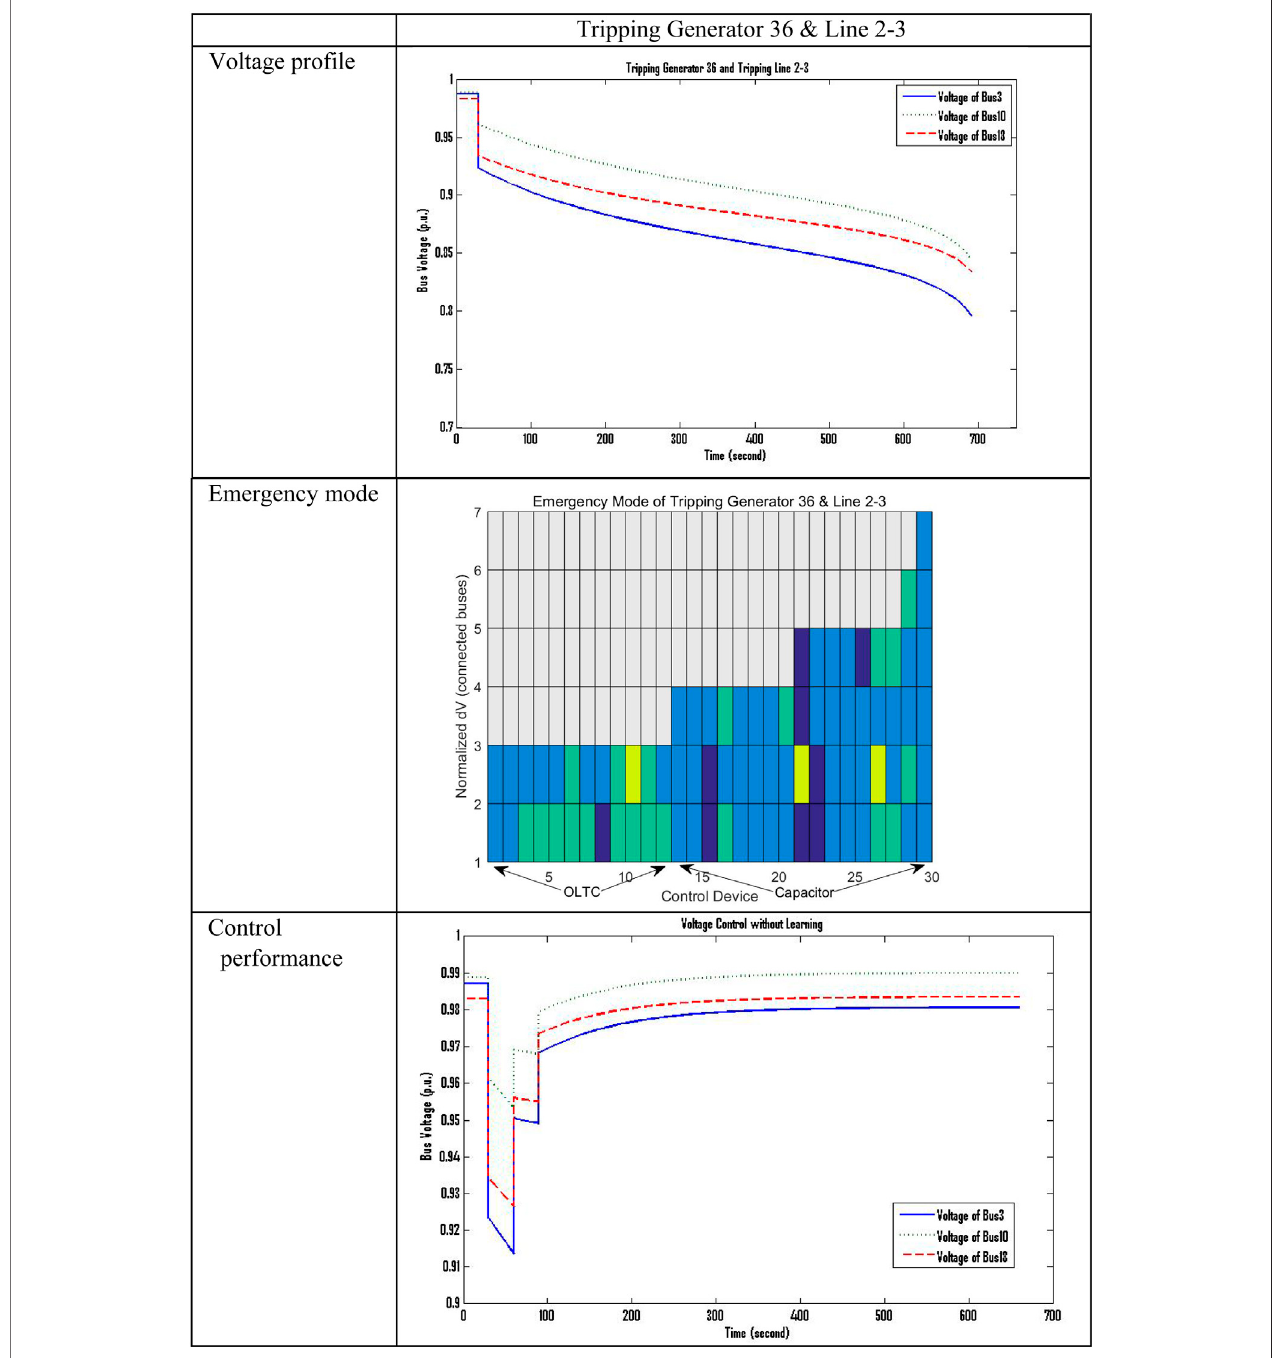
FIGURE 7 | Emergency control: Tripping Generator 36 and Tripping Lines 2,